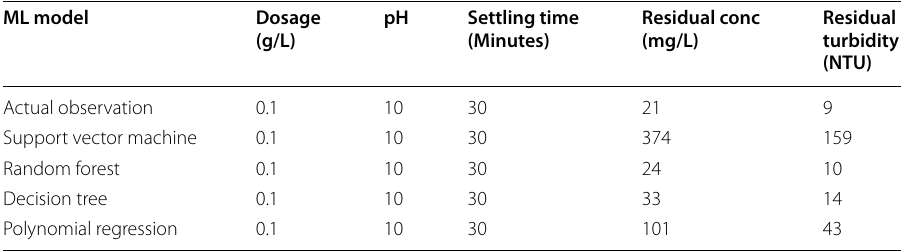
Table 4 ML model performance in terms of predicted